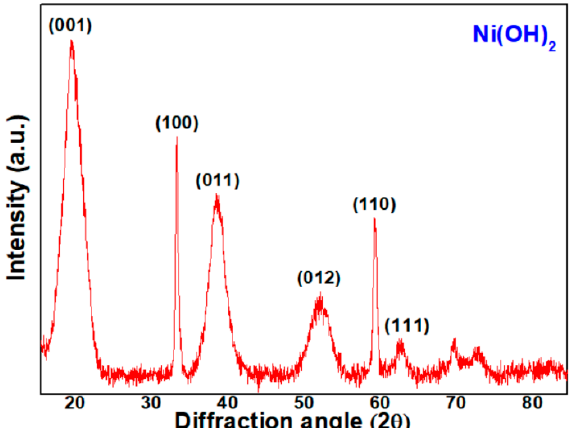
Figure 1. XRD pattern of the precipitate from Ni(II) acetate with ammonia.